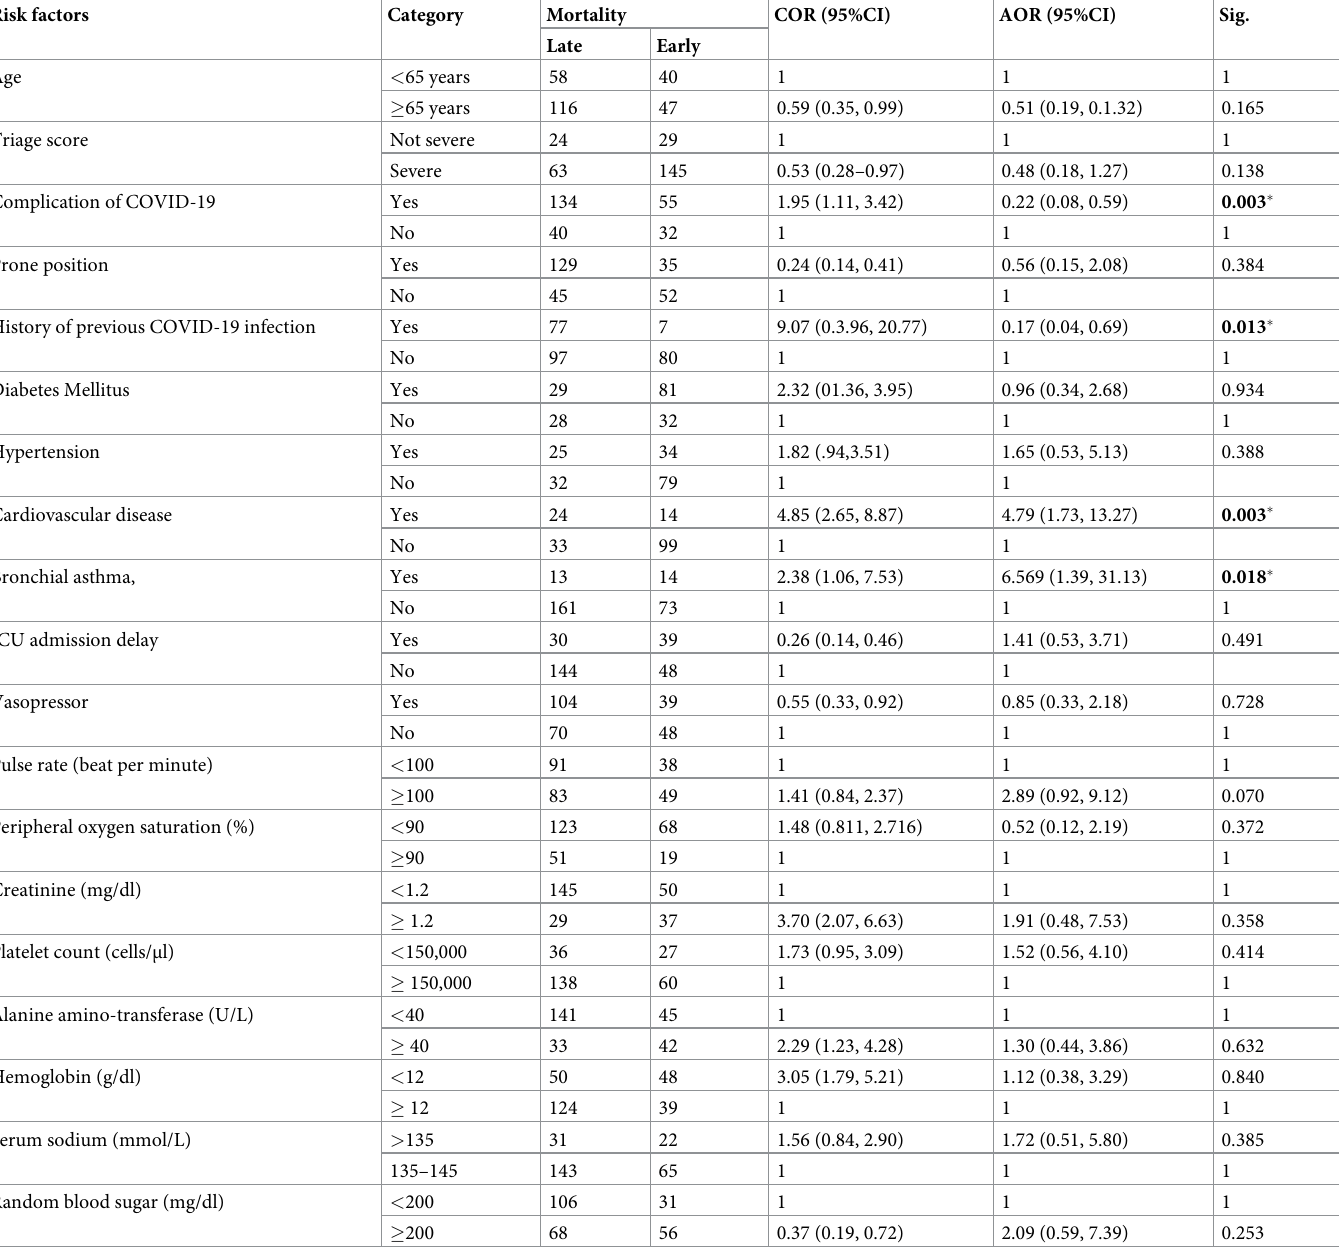
Table 5. Bivariate and multivariate analysis of risk factors associated with early mortality after ICU admission among COVID-19 patients at Addis Ababa COVID 19 care centers, Ethiopia, 2022 (n =